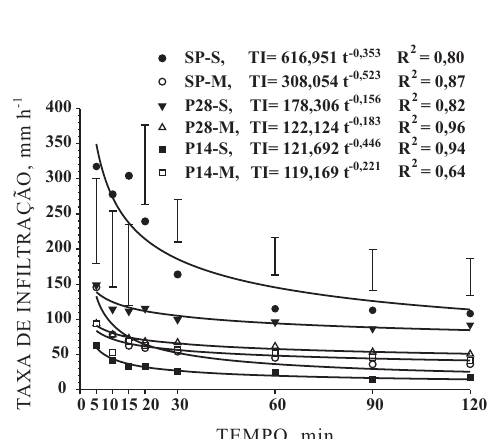
Figura 3. Taxa de infiltração de água em um Argissolo Vermelho-Amarelo alumínico sob diferentes sistemas de manejo de uma pastagem de inverno, tendo como culturas de verão antecessoras soja e milho (SP: sem pastejo; P28: pastejo a cada 28 dias; P14: pastejo a cada 14 dias; S: soja; M: milho). As barras verticais correspondem à diferença mínima significativa pelo teste de Tukey (p <